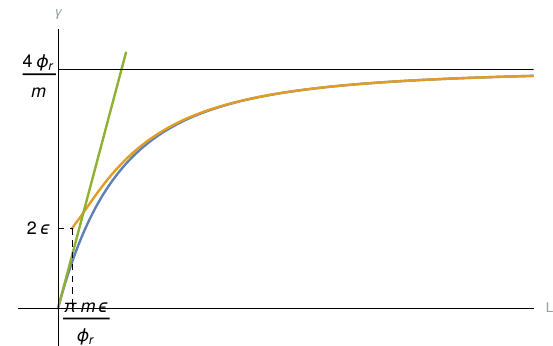
Figure 8 . Numerical solution to (5.40) and (5.39) when mass is positive. The blue line is the conformal result, the orange line is the full solution, and the green line is the solution with R (cid:24) y , or (cid:30) b =m taken to be